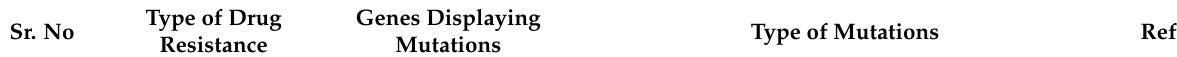
Table 1. Types of genetic mutations in mycobacteria leading to resistance against first-line drugs. * Represents found in Drug-resistant and/or Drug-sensitive